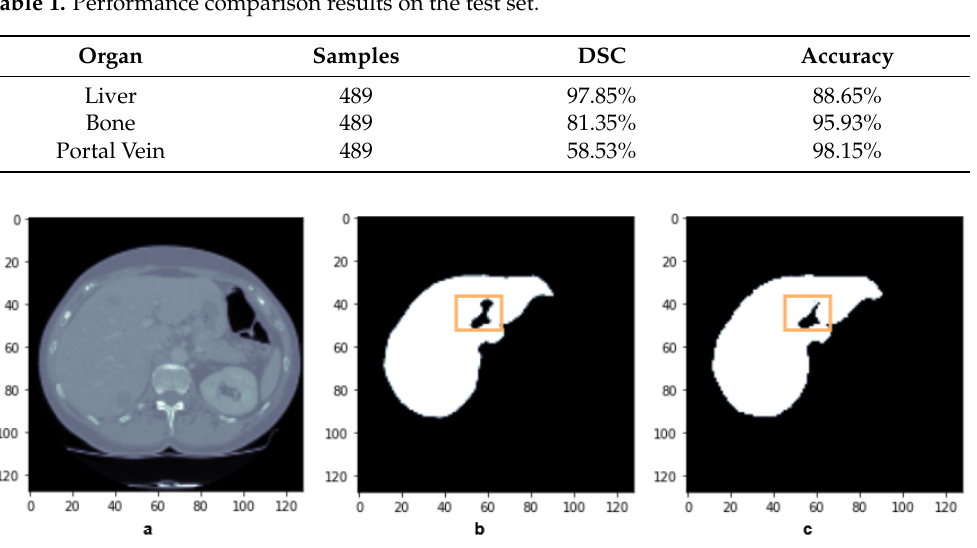
Figure 6. Sample image ( a ), original mask ( b ) and predicted mask ( c ) for the liver.